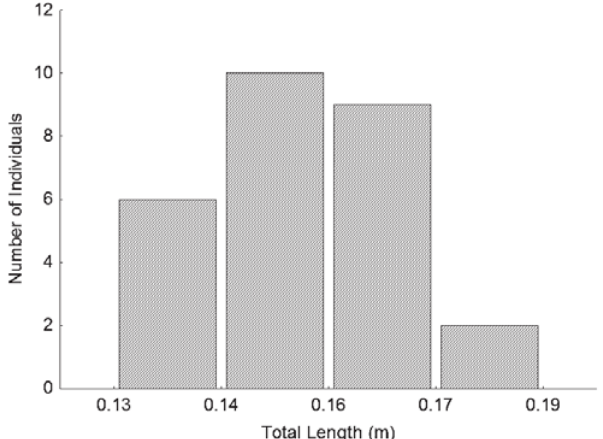
Fig. 2. Number of tested fish per total length classes used to determine prolonged speed.